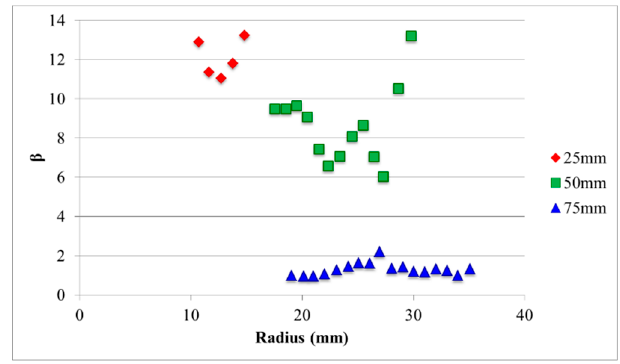
Figure 13. Droplet aspect ratio at axial distances of 25, 50, and 75 mm with non-swirling atomizing air.